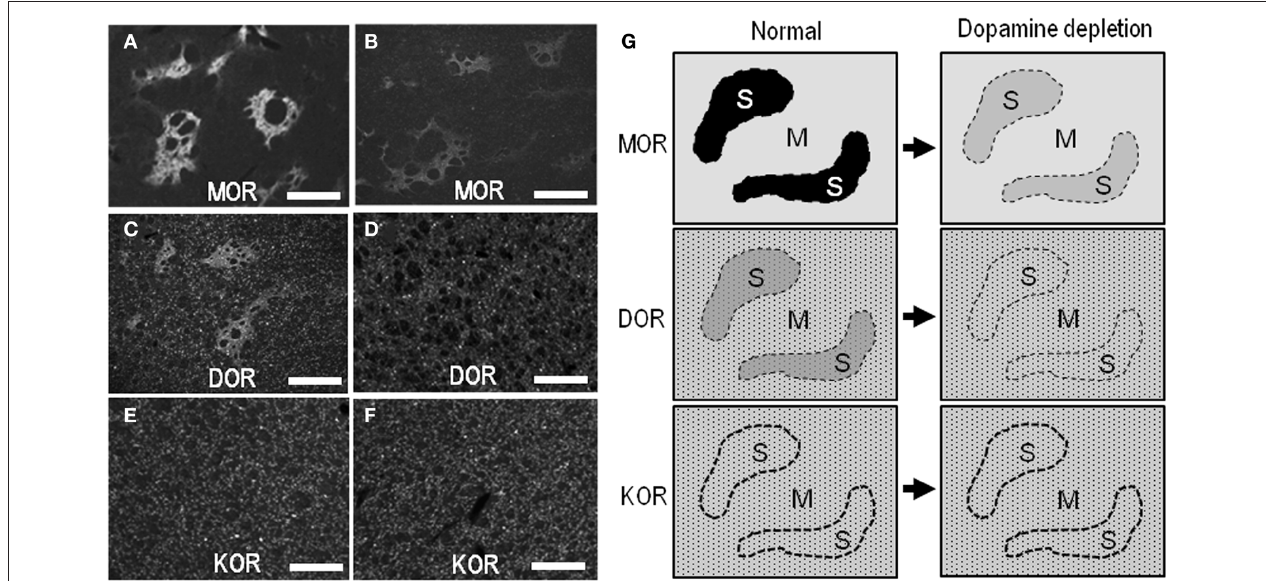
FIGURE 7 | Light microscopic localization of MOR, DOR, and KOR in the dorsal striatum and its alterations following dopamine depletion. (A–F) Representative microscopic images of the striatal sections stained for MOR (A and B) , DOR (C and D) , and KOR (E and F) on the non-lesioned (A,C , and E) and lesioned (B,D ,and F) sides.Scalebar = 200 μ m. (G) Summaryofpatternedloss